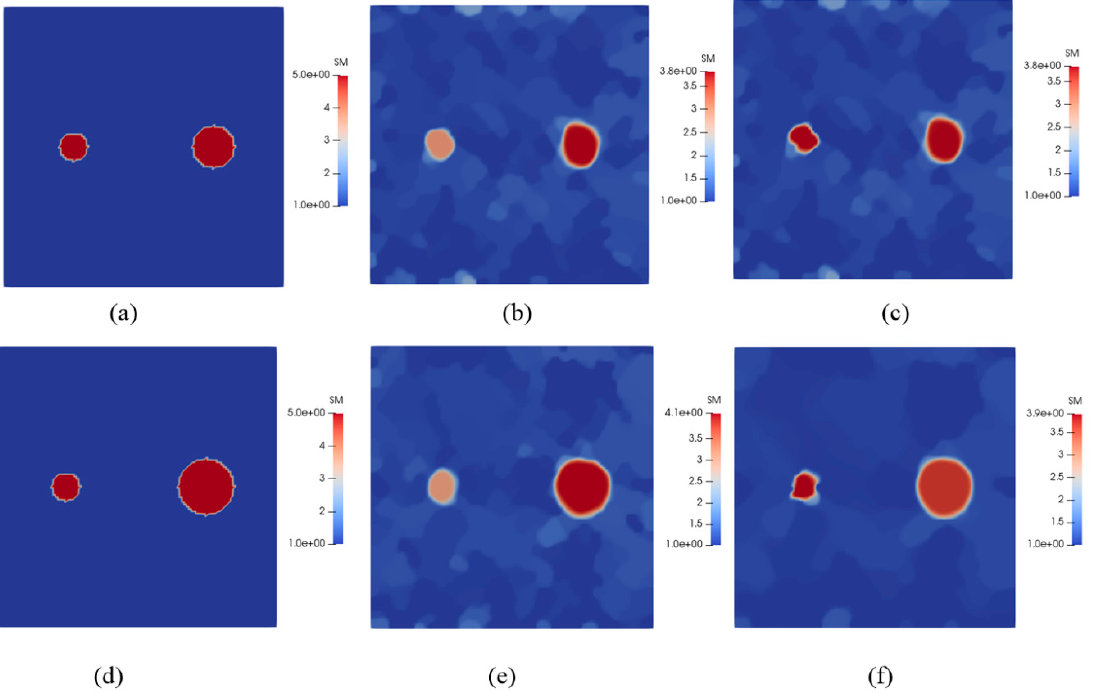
Figure 3. In the first row, the target and reconstructed shear modulus distributions, where the target right inclusion is 1.5 times as large as the left one, are shown. In the second row, the target and reconstructed shear modulus distributions, where the target right inclusion is twice as large as the left one, are presented. ( a ) Target shear modulus distribution where the right inclusion is 1.5 times as large as the left one. ( b ) Reconstructed shear modulus distribution with the regularization factor of 2.0 × 10 − 10 , utilizing the standard method. ( c ) Reconstructed shear modulus distribution with the regularization factor of 2.0 × 10 − 10 , utilizing the proposed method. ( d ) Target shear modulus distribution where the right inclusion is twice as large as the left one. ( e ) Reconstructed shear modulus distribution with the regularization factor of 2.0 × 10 − 10 utilizing the standard method. ( f ) Reconstructed shear modulus distribution with the regularization factor of 4.0 × 10 − 10 utilizing the proposed method.